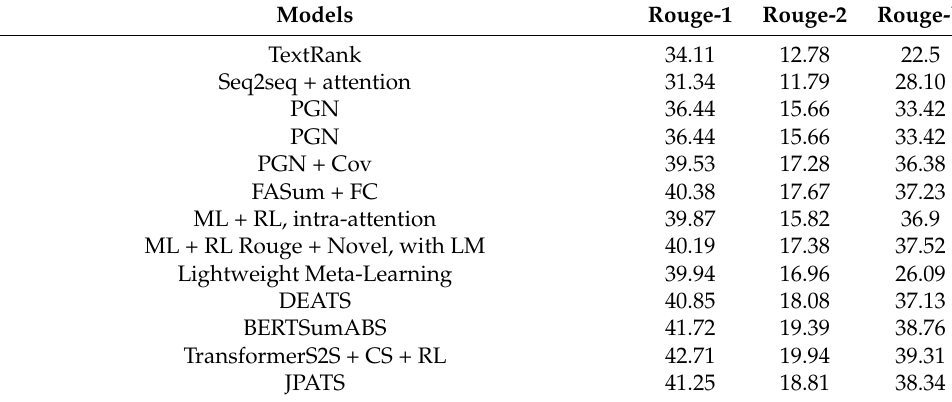
Table 1. Rouge scores of JPATS on the dataset CNN/DailyMail.